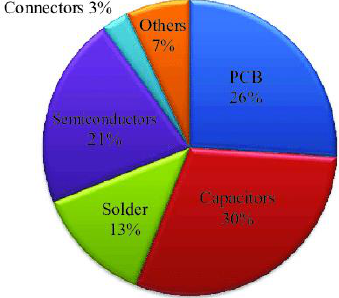
Figure 2. Contribution to converter’s failure rate from various components of a PoL converter